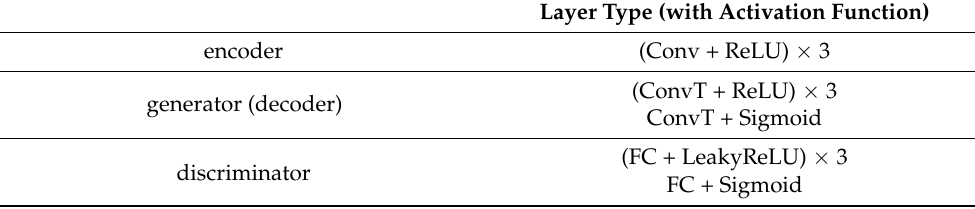
Table 2. Structure of